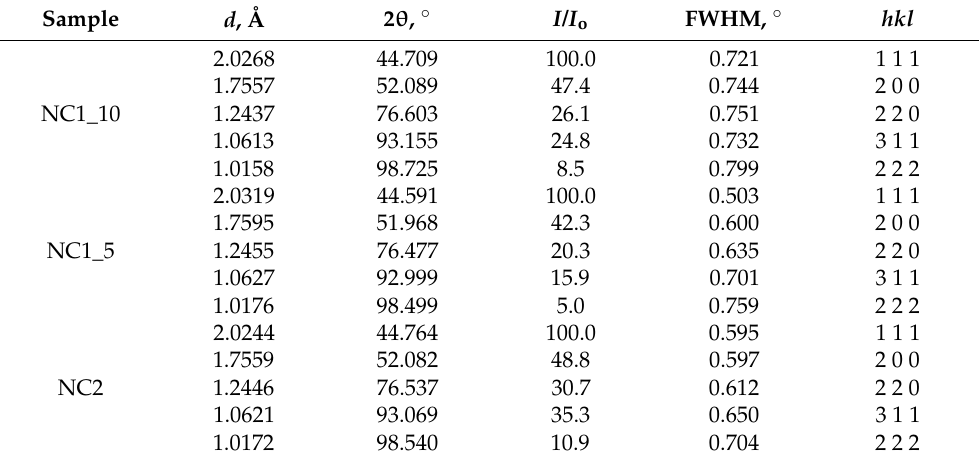
Table 2. Analysis of diffraction patterns of polycrystalline Ni in synthesized nanocomposites.